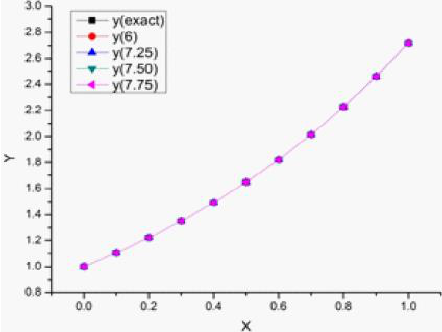
Figure 3: The Chebyshev solutions graph for the fractional differential equations given in Problem 3 of different order 